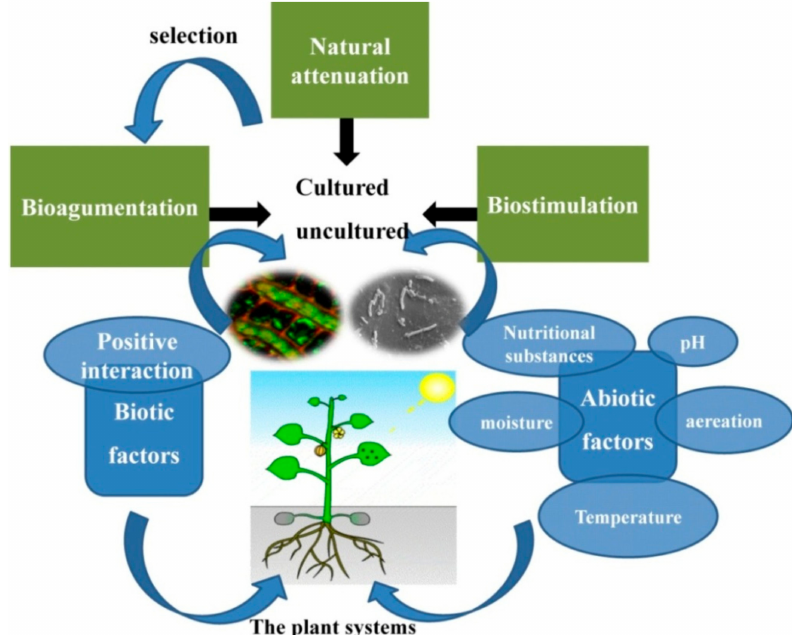
Figure 2. Biotic and abiotic factors a ff ecting plant-microbe interactions during phytoremediation and biotransformation processes. Oval images presents plant associated endophytes seen under the fluorescence and electron microscopes (photos taken by the